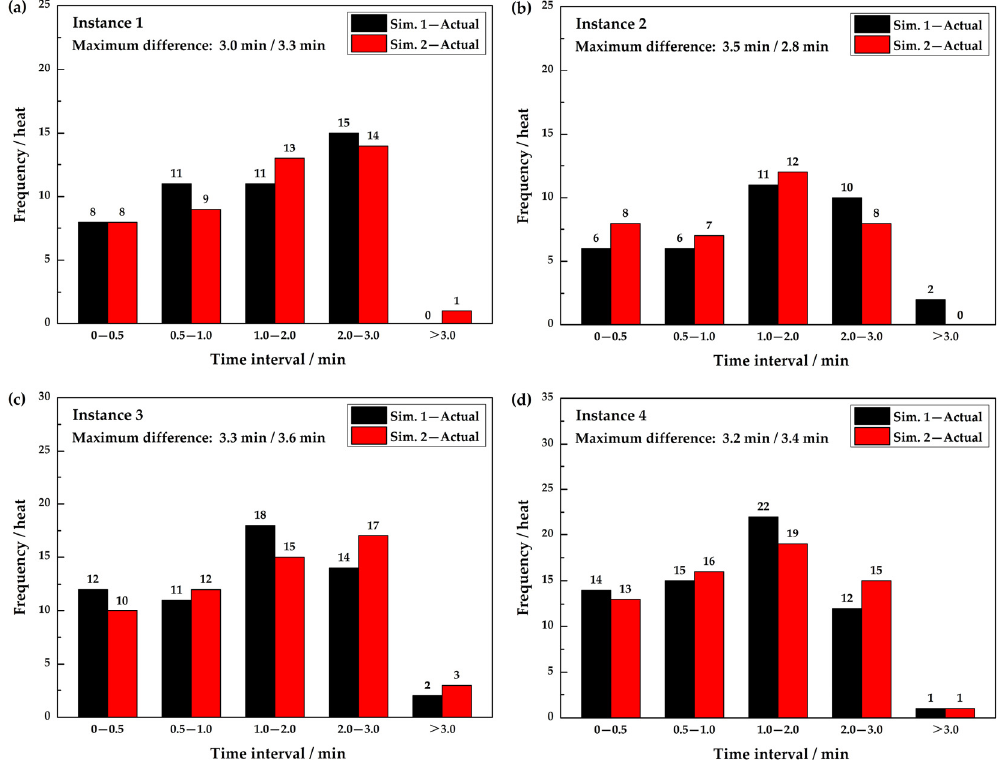
Figure 12. Distributions on the differences between the simulated and the actual transfer times from BOF to LF.